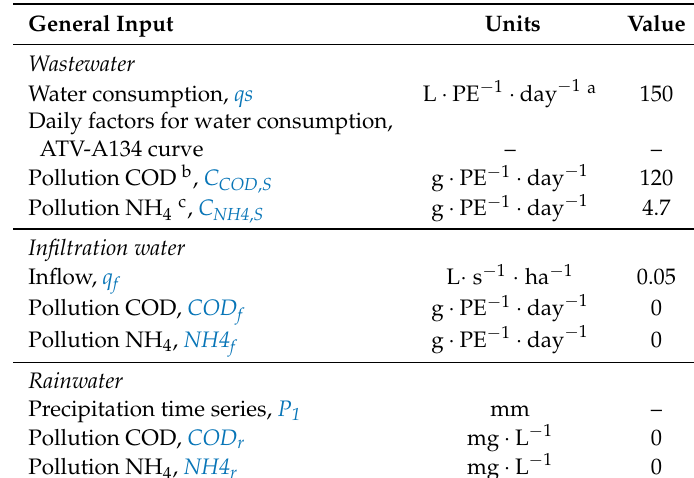
Table 5. General input data of the EmiStatR scalability test.